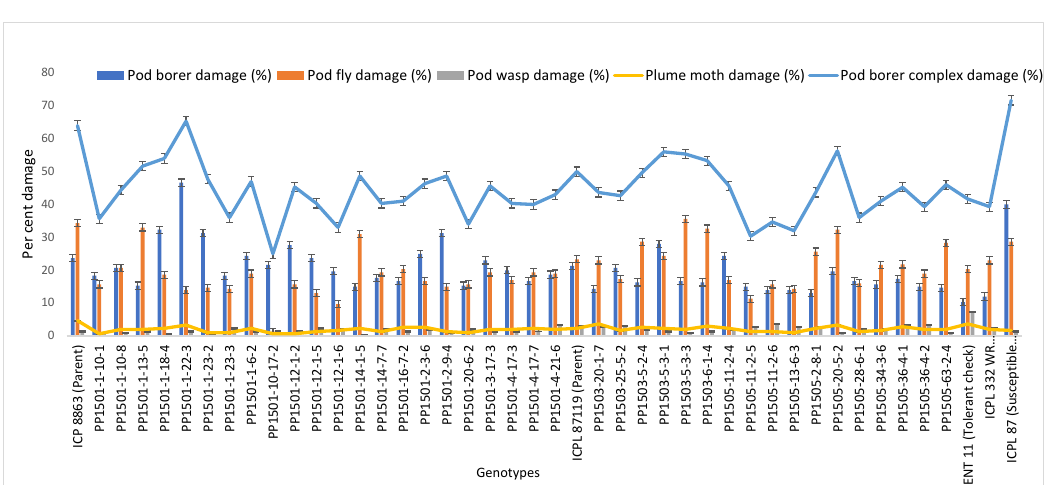
Figure 4. Confirmation of pod borer resistance in the most promising ILs during the 2020 rainy season at ICRISAT, Patancheru, India. Biology 2022 , 11 , x FOR PEER REVIEW